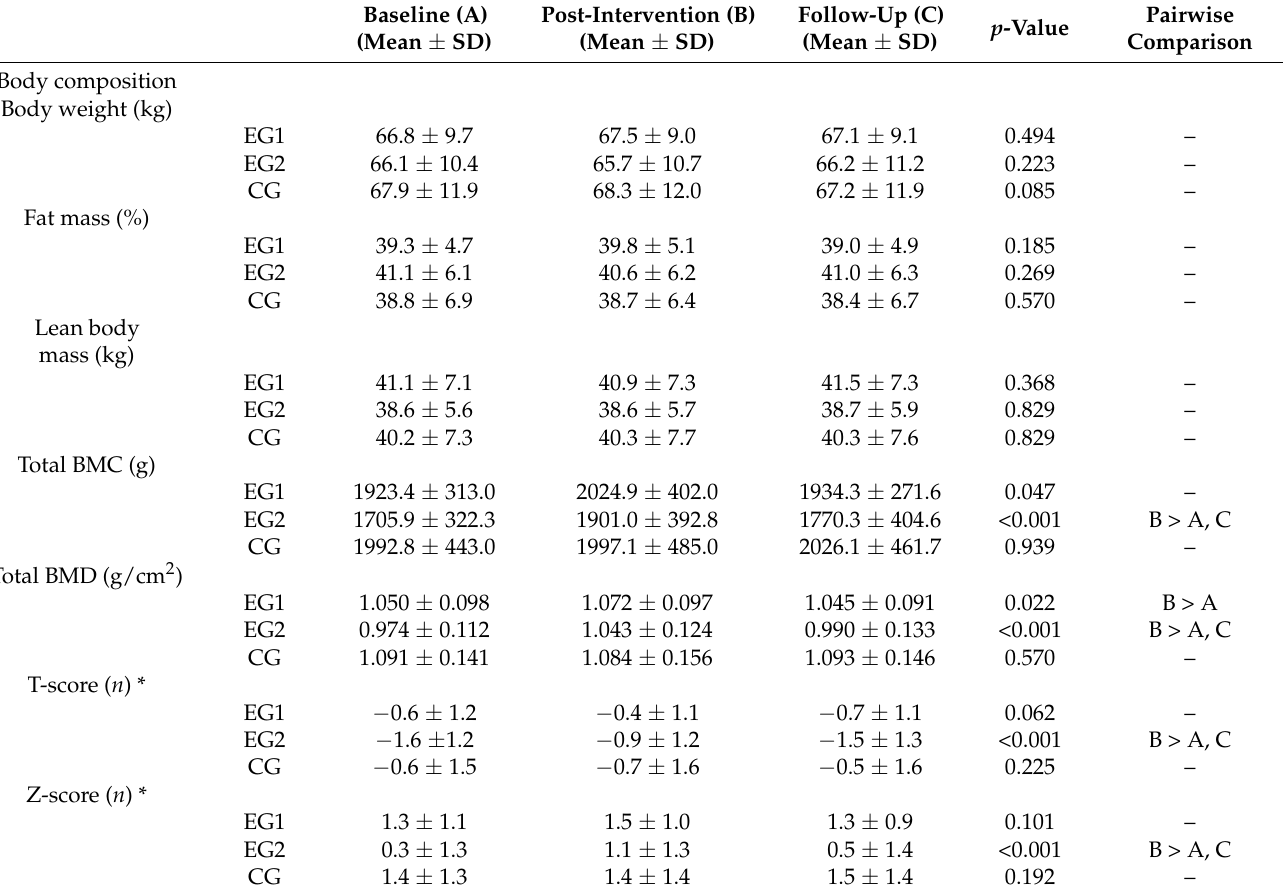
Table 2. Impact of the interactive cognitive–motor programs on body composition variables. Pairwise Baseline (A) Post-Intervention (B) Follow-Up (C) p -Value (Mean ± SD) (Mean ± SD) (Mean ± SD)